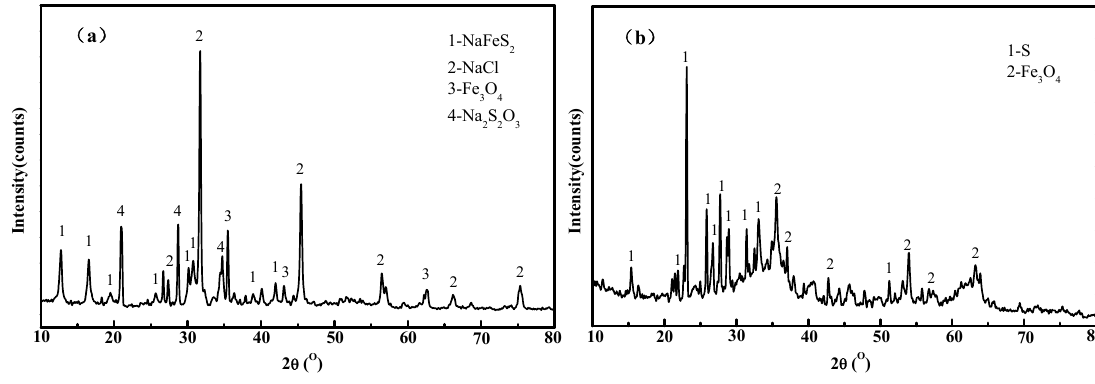
Figure 11. XRD analysis of molten slag and its residue after leaching. ( a ) molten slag; ( b ) residue.